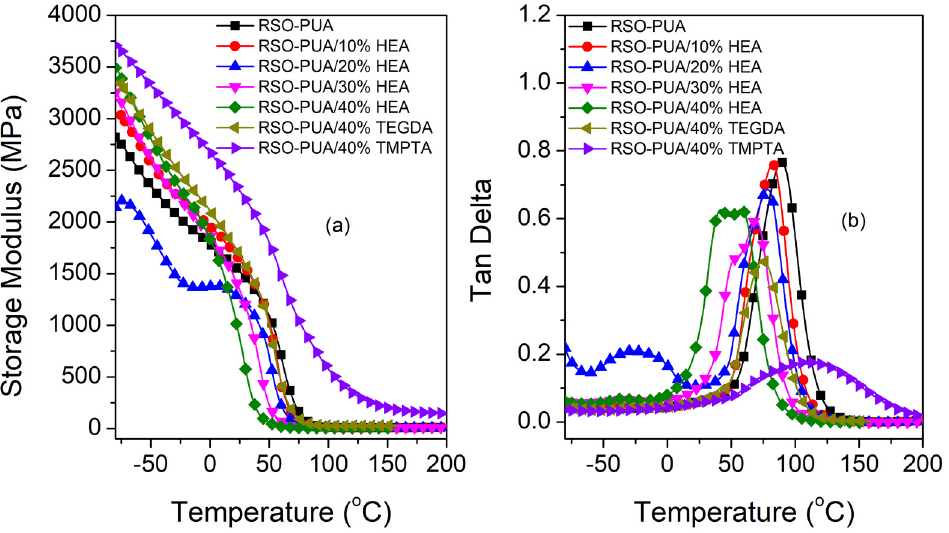
Figure 3. ( a ) Storage modulus and ( b ) loss factor versus the temperature of the UV-cured RSO-PUA materials. Table 2. Thermal properties of the cured RSO-PUA resins.